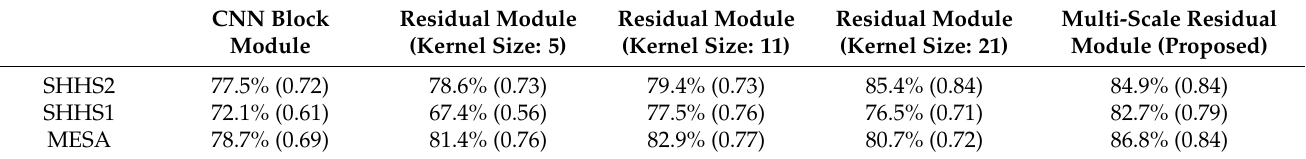
Table 5. Comparison of sleep staging with different feature